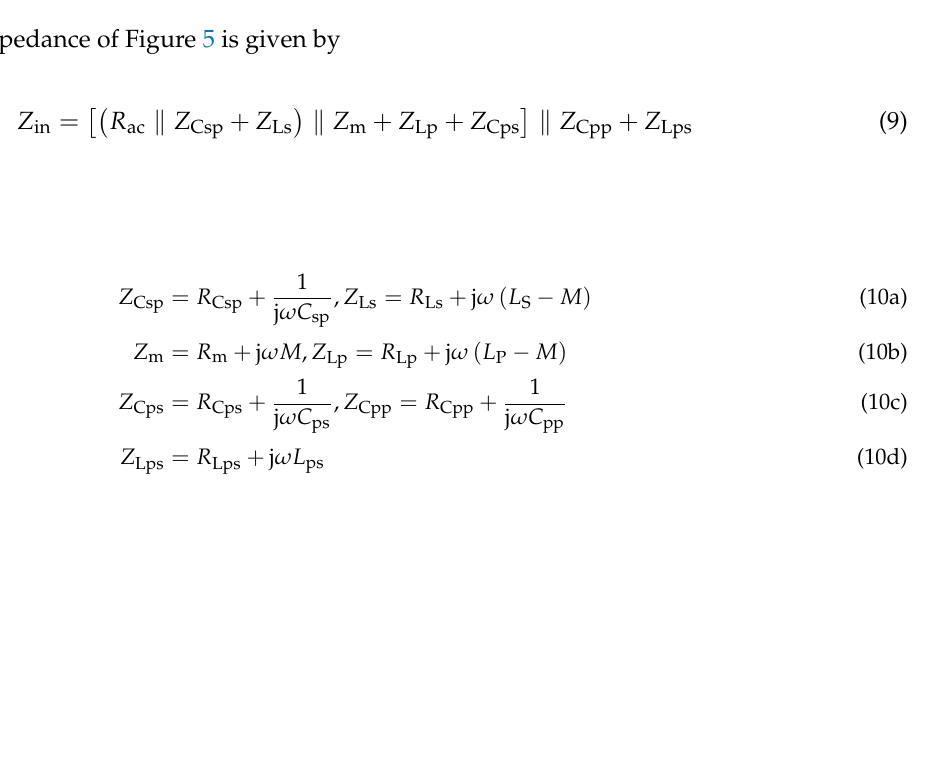
Figure 5. Equivalent circuit of the LCC-parallel compensation topology with resonant circuit losses